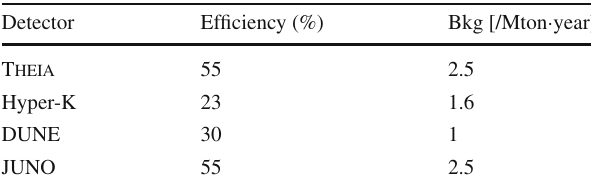
Table 8 Detection efficiency and background rates for p → ¯ ν K + . Theia and JUNO are assumed to have the same relative efficiency, whichisdominatedbytheshortlifetimeofthekaon.Hyper-Kefficiency is the lowest due to being unable to detect the kaon since it is below the Cherenkov threshold